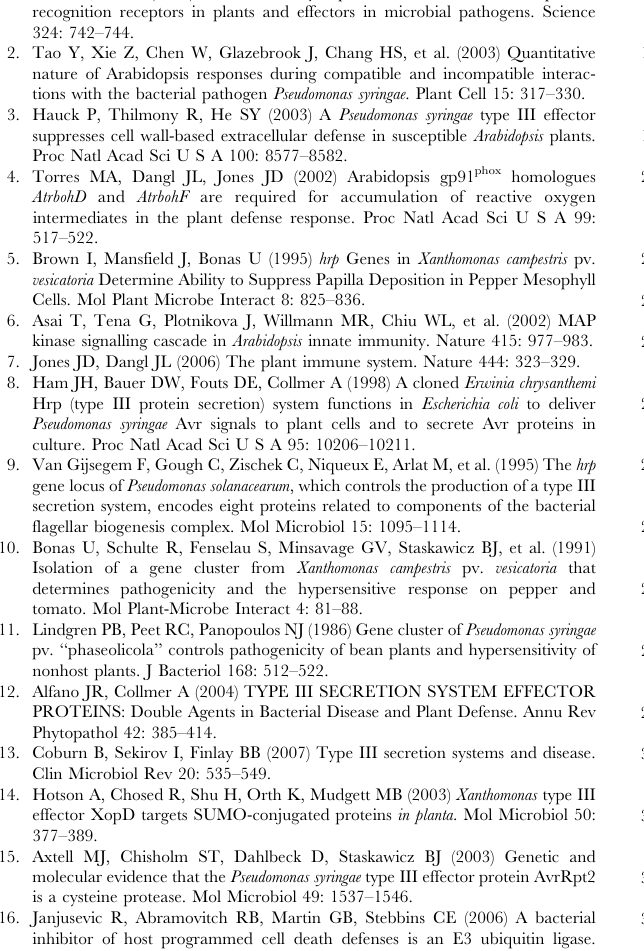
Table S1 List of primers used in this